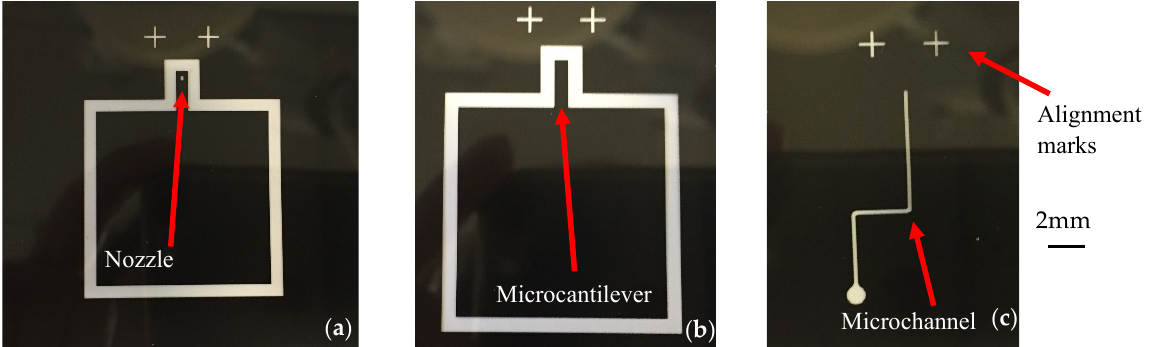
Figure 3. Negative masks printed for photo lithography process: ( a ) nozzle mask, ( b ) microcantilever mask, and ( c ) microchannel mask.